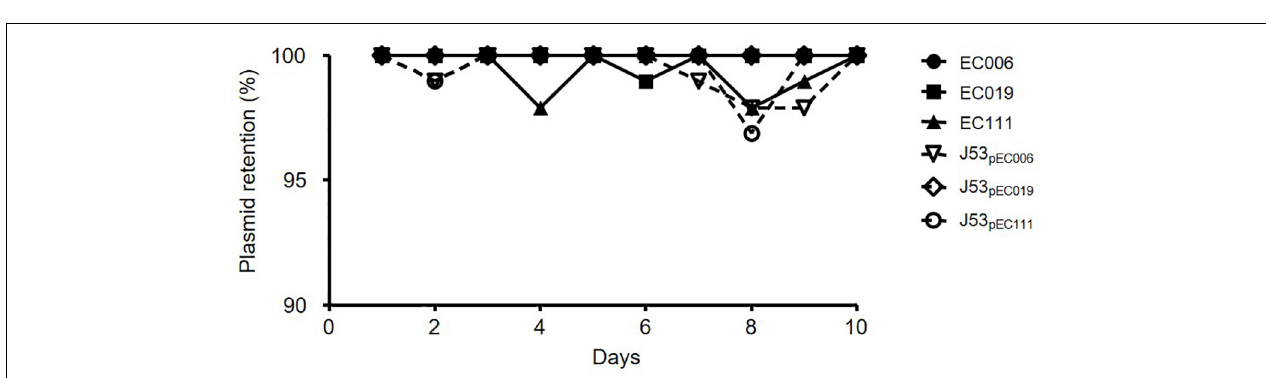
FIGURE 1 | mRNA expression levels of pmrA, phoP , and eptA . The mRNA expression was measured by qRT-PCR. (A–C) Comparison of expression levels of pmrA, phoP, and eptA between CL-S and CL-IR strains. The expression levels in a reference strain MG1655 are also presented. (D–F) Comparison of expression levels of pmrA, phoP , and eptA between a reference strain MG1655, CL-chrR, and CL-mcrR strains. Statistics were done with unpaired, two-tailed t -test. * P ≤ 0.05; ** P ≤ 0.01; *** P ≤ 0.0001; ns, not significant.